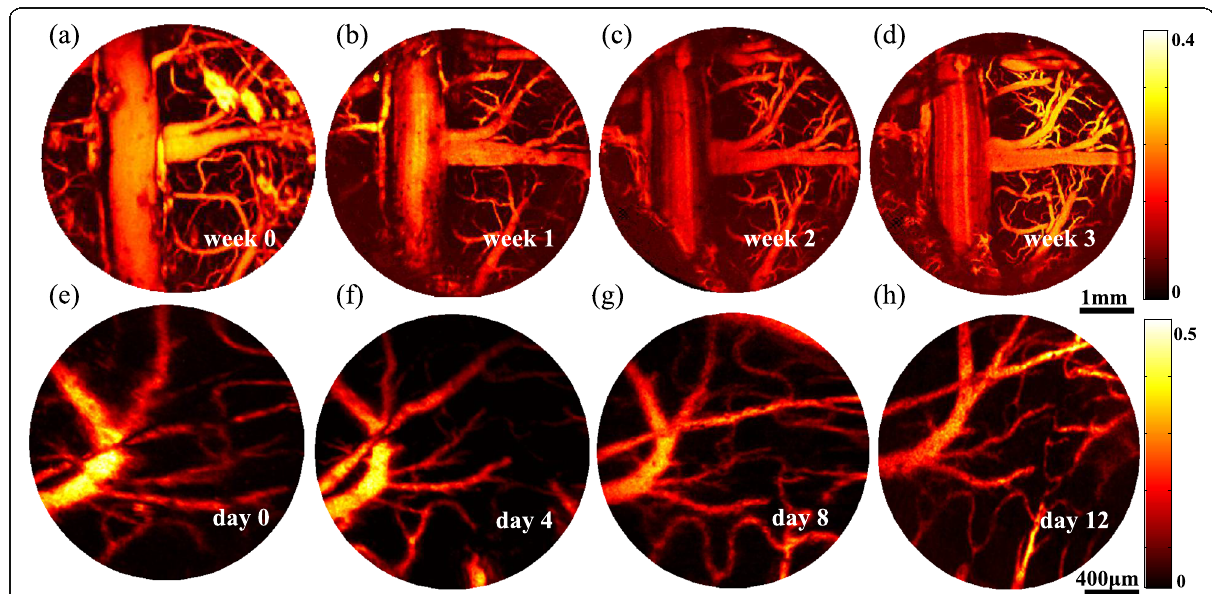
Fig. 7 Long-term in vivo PAI in both anesthetized and freely moving rats [62]. a - d Four typical PA images captured at 0, 1, 2, 3 weeks post- implantation in anesthetized rats. e - h Four typical PA images captured at 0, 4, 8, and 12 days post-implantation in freely moving